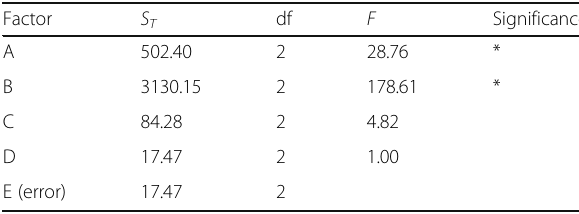
Table 4 Analysis of